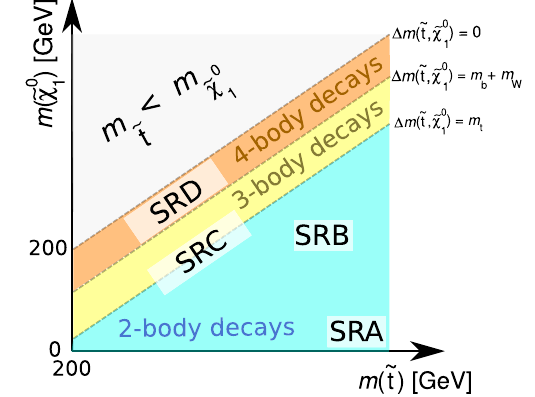
Fig. 2 Schematic representation of the various topologies targeted by the different signal regions defined in the analysis (SRA, SRB, SRC, SRD). SRA and SRB are orthogonal and the exact requirements made in the signal regions are detailed in the text and Table